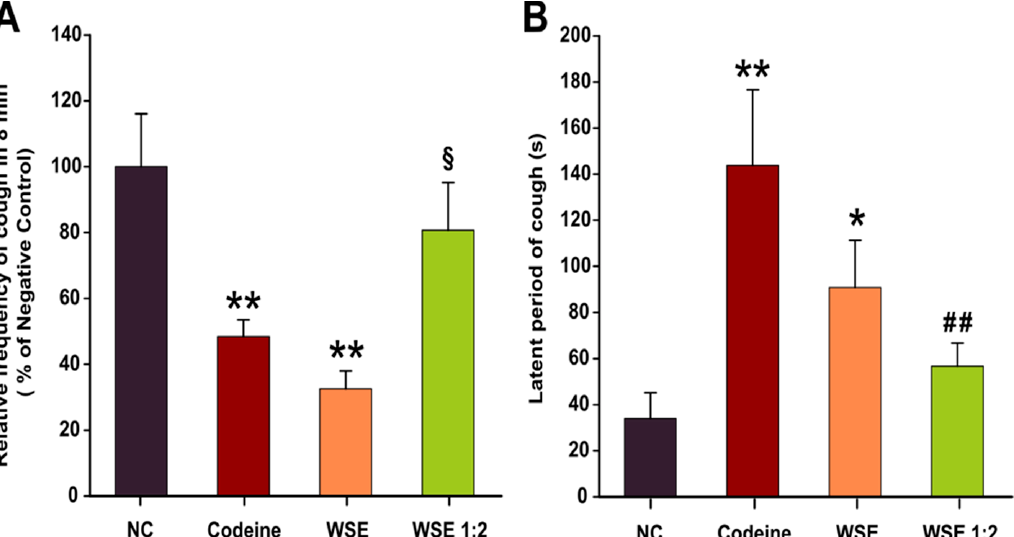
Figure 1. The antitussive activities of codeine, WSE, and WSE 1:2. Relative frequency of cough in 8 min ( A ) and Latent period of cough ( B ). Data are presented as the mean ± SEM ( n = 6). * p < 0.05 and ** p < 0.01 compared to NC; ## p < 0.01 compared to Codeine); § p < 0.05 between the two concentration of WSE. Statistical significance differences in datasets were determined with one-way ANOVA with the Holm-Sidak post hoc test. NC—negative control; WSE—walnut septum extract; WSE 1:2—walnut septum extract diluted 1:2. Table 1. Effects of different treatments on the citric acid-induced cough in